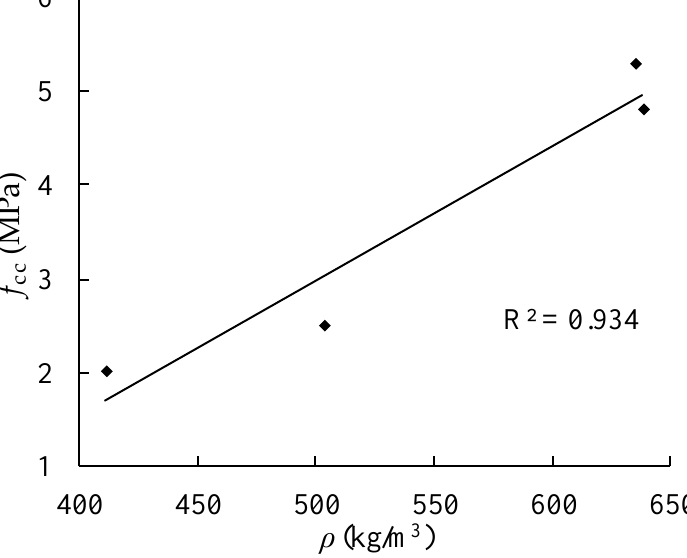
Figure 14. Relationship between cubic compressive strength and apparent density of AAC. From Table 8, the strength of AAC is lower than that of base materials. This is because the existence of pores greatly reduces the strength of AAC. Compared with B05 and B06FA AAC, under the same other conditions, the apparent density and cubic compres- sive strength decrease with the increase of aluminum paste content.